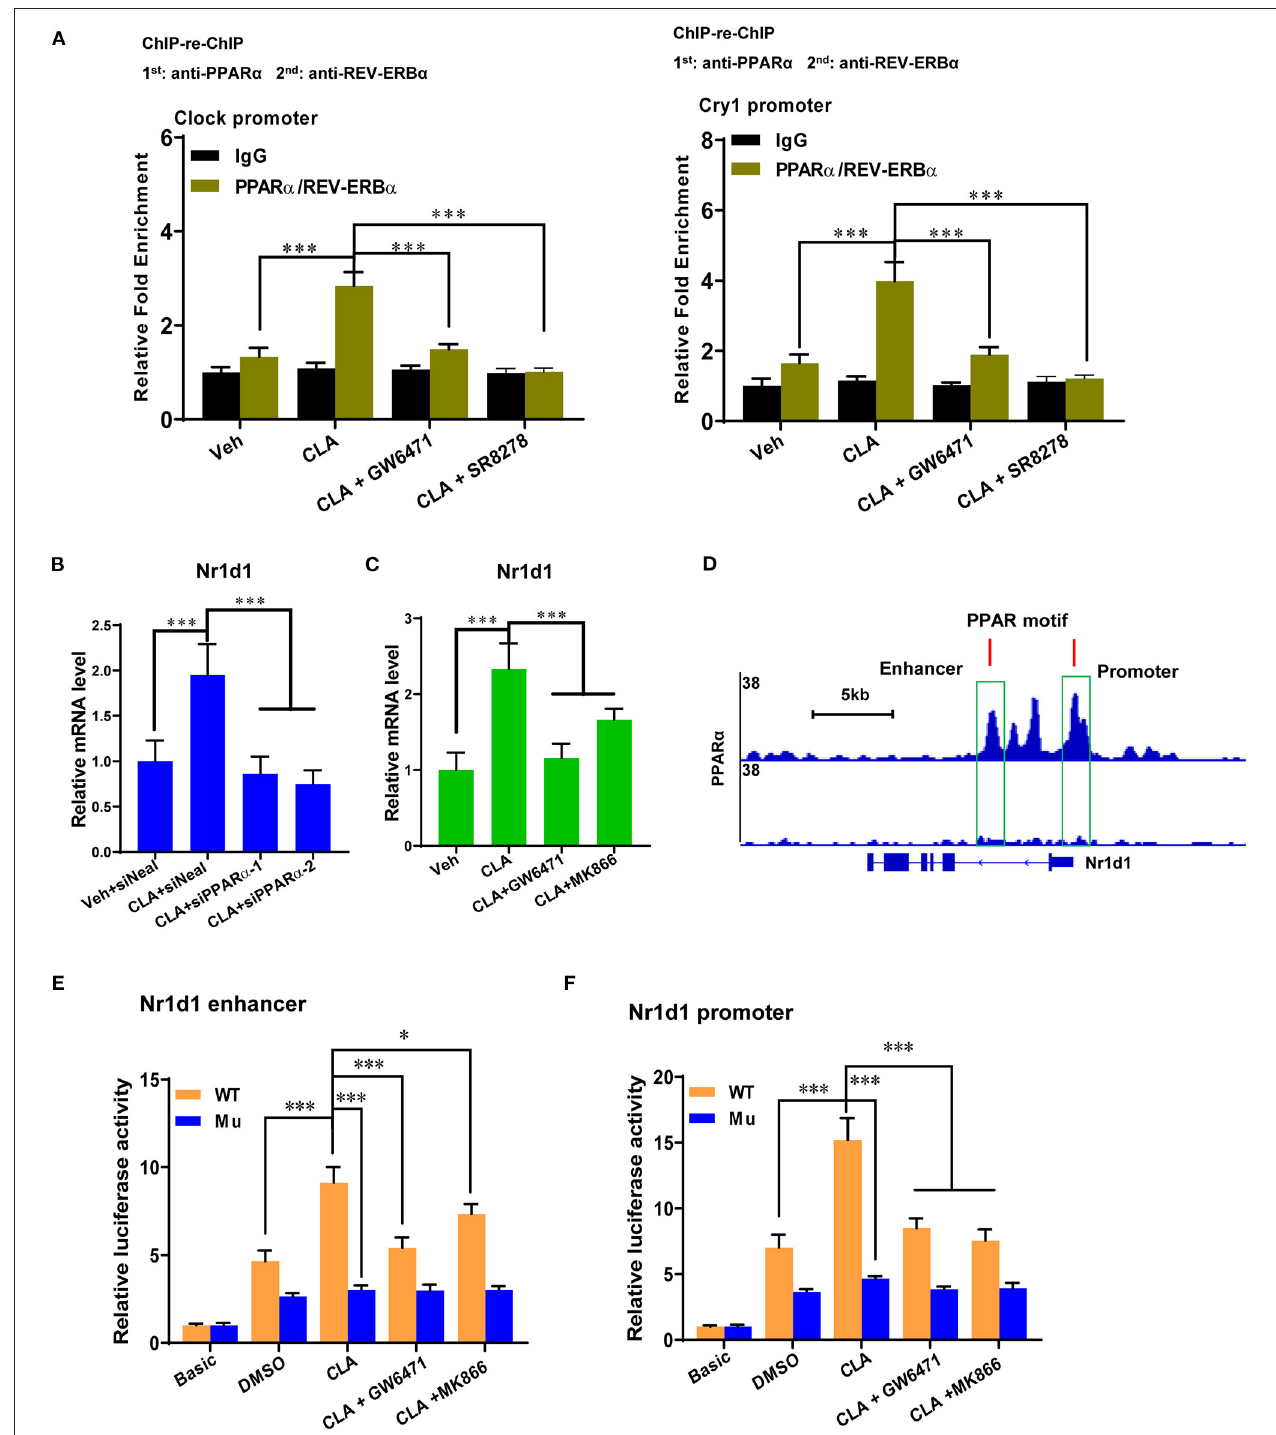
FIGURE 5 | PPAR α determines REV-ERB α -mediated transcription repression of circadian genes. (A) ChIP-re-ChIP analysis with CLA-treated mice derived primary hepatocytes treated with GW6471, SR8278 or vehicle for 48h. The cell extracts were used for ChIP and re-ChIP with indicated antibodies. DNA from the second ChIP was analyzed at the promoters of Clock and Cry1 by real-time PCR. The experiments were repeated three times. (B,C) Relative mRNA levels of Nr1d1 (REV-ERB α ) in Veh or CLA-treated mice derived primary hepatocytes when PPAR α was inhibited by siRNAs or antagonists. (D) PPAR α -binding motif at the promoter and the enhancer of REV-ERB α gene ( Nr1d1 ) in ChIP-seq genome-wide browser analysis. (E,F) Relative luciferase expression of PPAR α at the Nr1d1 enhancer or promoter with the wild-type or mutated PPRE in hepatocytes treated with vehicle (DMSO), CLA, cotreatment of GW6471 or MK866 with CLA for 24h and determined by the reporter gene assay. The data are shown as the means ± SD, n = 6. The experiments were repeated three times. * p < 0.05, *** p < 0.001, using two-tailed student’s t -test or ANOVA with Tukey’s post hoc test.